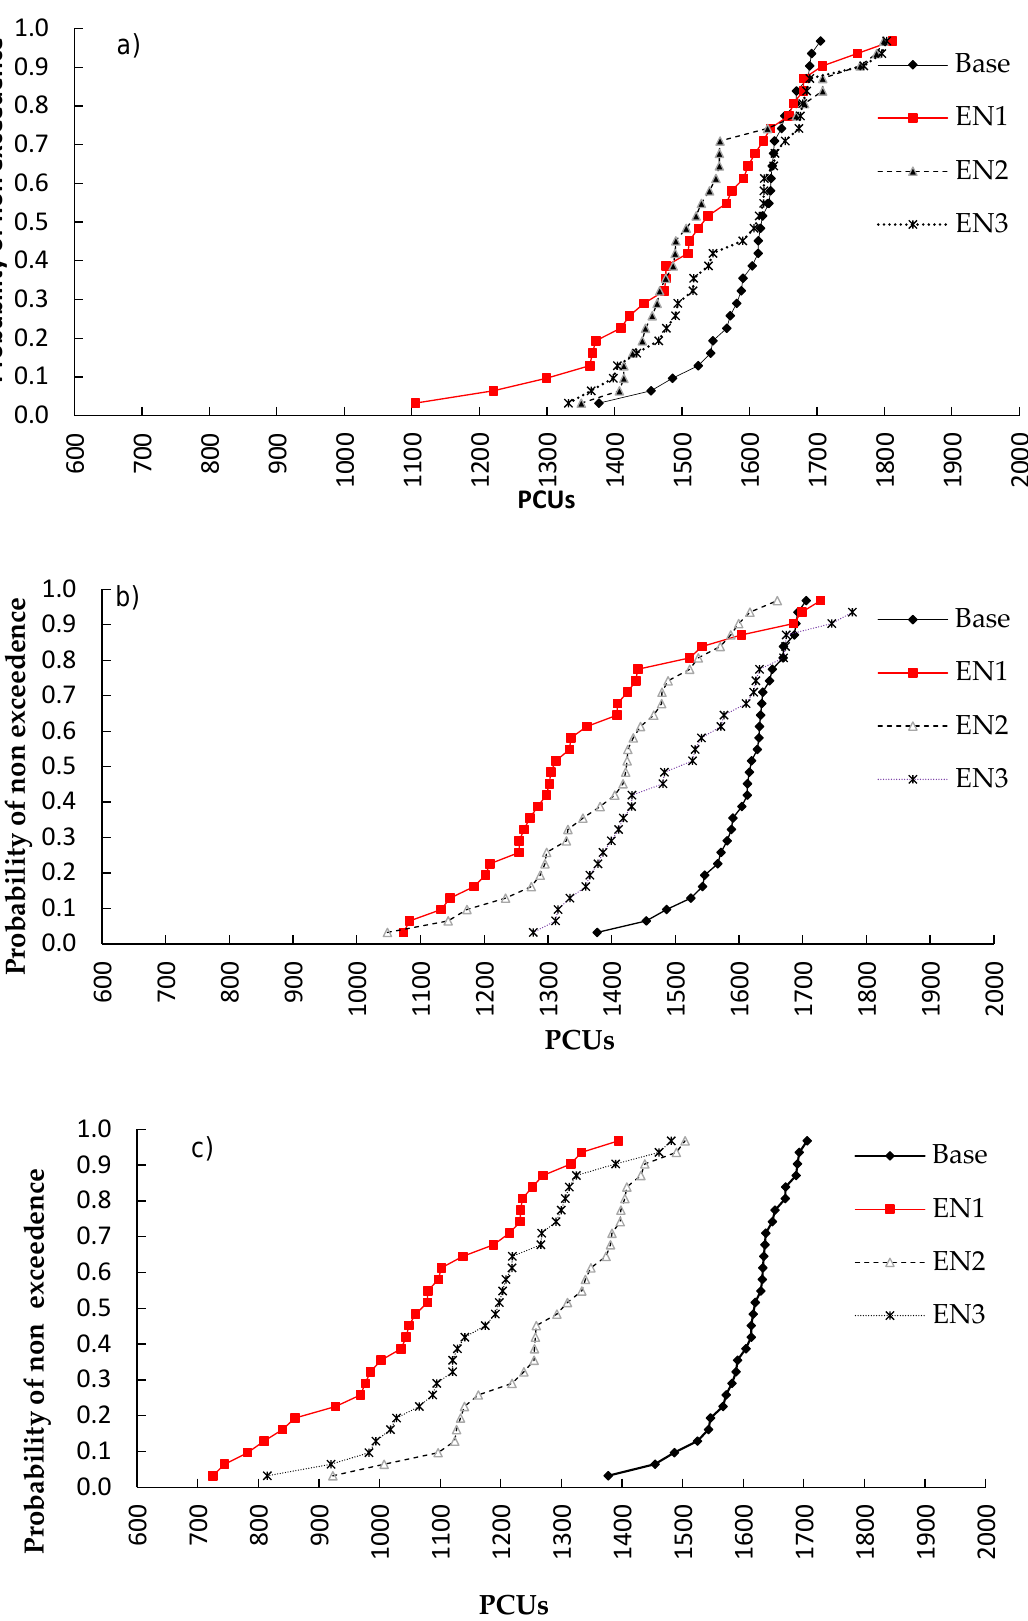
Figure 4. Cumulative distribution function of accumulated positive chill units (PCUs) for Ceres for the period ( a ) 2011–2040, ( b ) 2041–2070, and ( c ) 2071–2100.